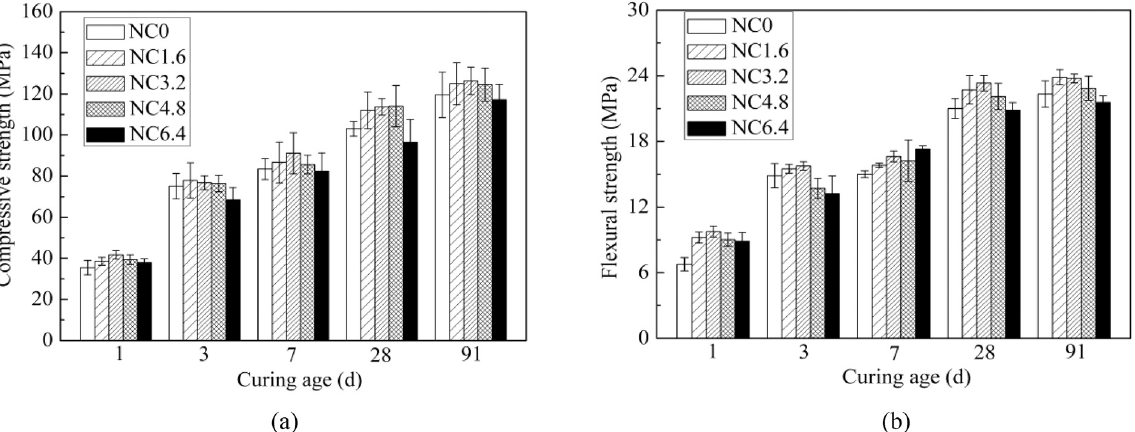
Figure 4: E ff ect of the content of nano - CaCO 3 on the strength of ultra - high strength concrete: ( a ) compressive strength and ( b ) fl exural strength [ 56 ] .